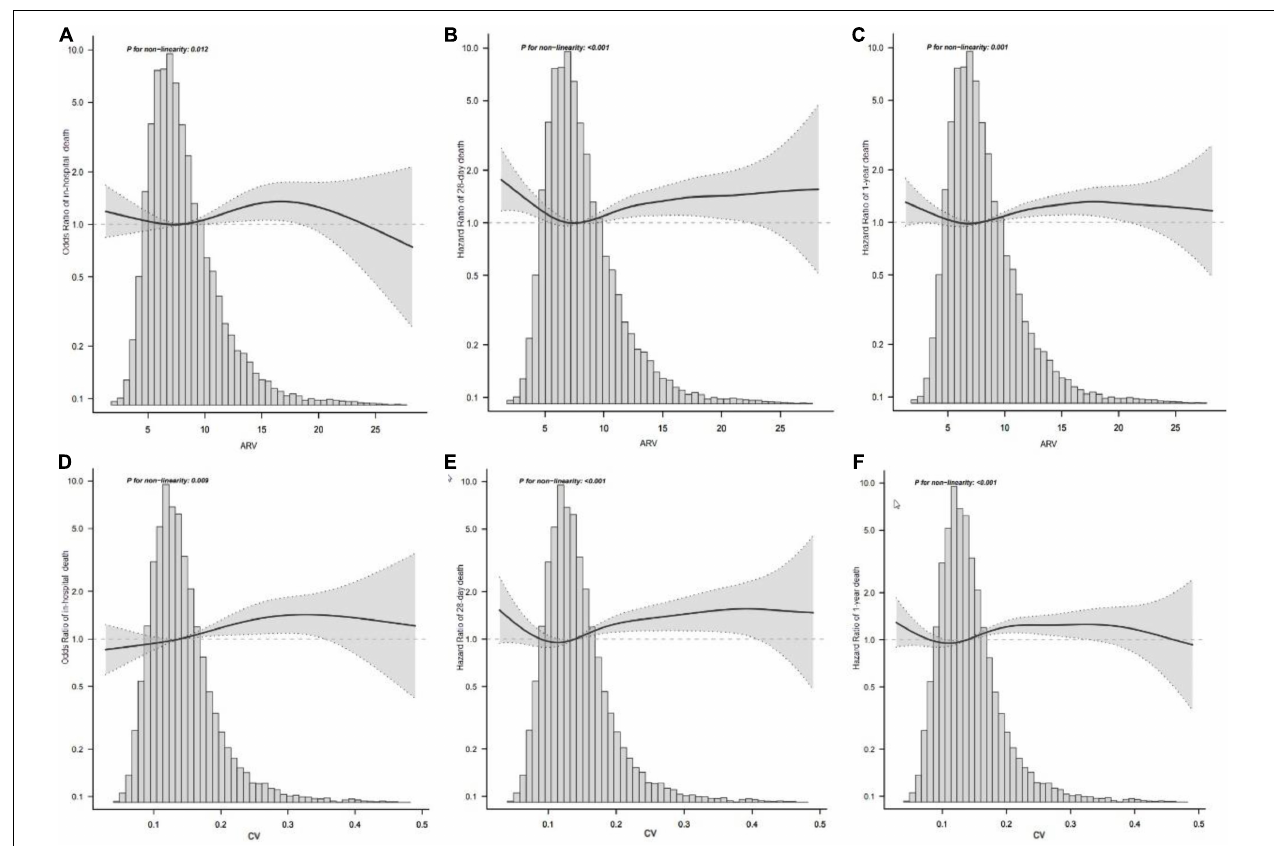
FIGURE 2 | Association between MAP variability and mortality. Smooth spline plots of the association between MAP ARV and in-hospital mortality (A) or 28-day mortality (B) or 1-year mortality (C) , and the relationship between MAP CV and in-hospital mortality (D) or 28-day mortality (E) or 1-year mortality (F) . ARV, average real variability; CV, coefficient of variation; MAP, mean arterial pressure.